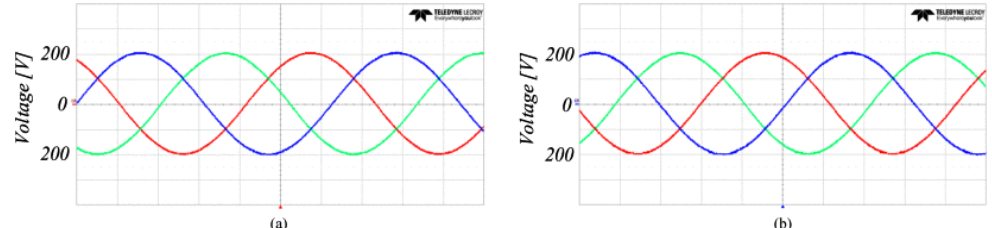
Figure 27. Comparison of different controllers with an ideal model. ( a ) MPC performance. ( b ) MFPC